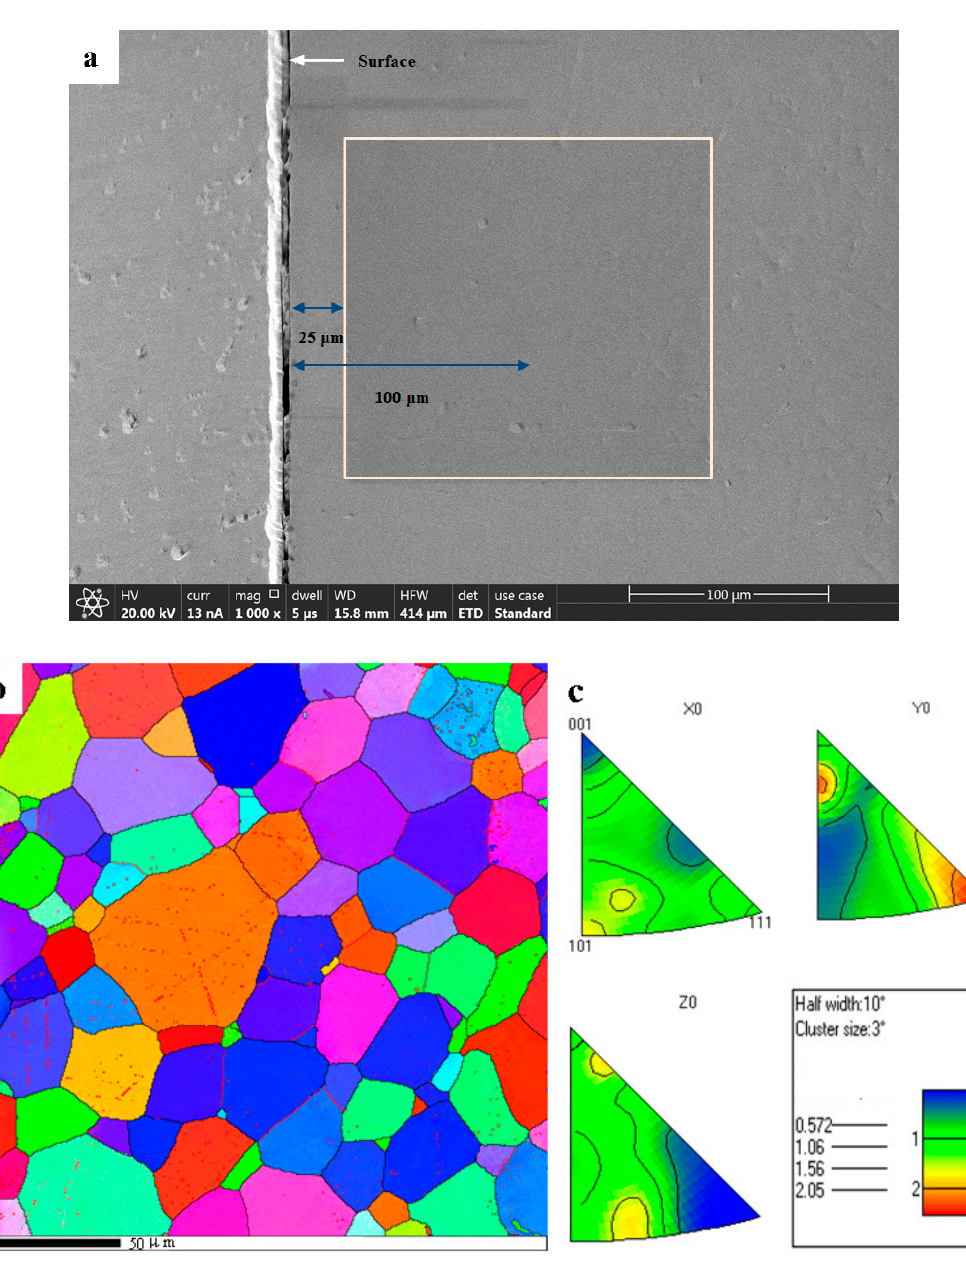
Figure 4. EBSD analysis results: ( a ) Scanning zone; ( b ) grain boundary map; ( c ) inverse pole figure.